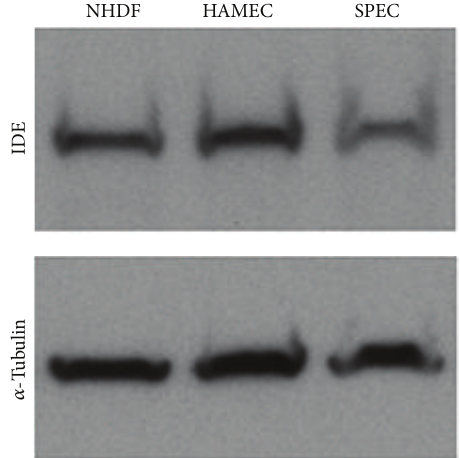
Figure 5: Prevascularized bioartificial pancreases express insulin degrading enzyme. SPECs, fibroblasts (NHDFs), and endothelial cells (HAMECs) were homogenized in sample loading buffer, resolved by SDS-PAGE, and immunoblotted for insulin degrading enzyme (IDE) and 𝛼 -tubulin. Robust expression of insulin degrad- ing enzyme was observed both in the cultured cells and in the assembled